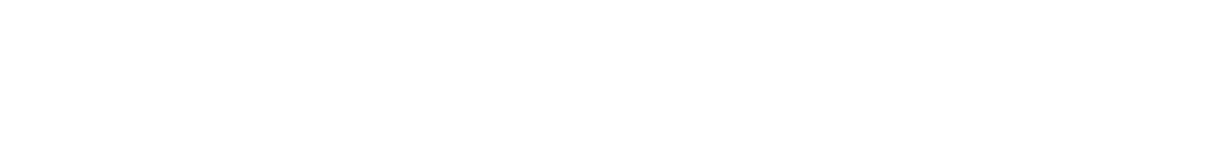
Frontiers in Immunology |T Cell Biology December 2011 |Volume 2 | Article 75 |